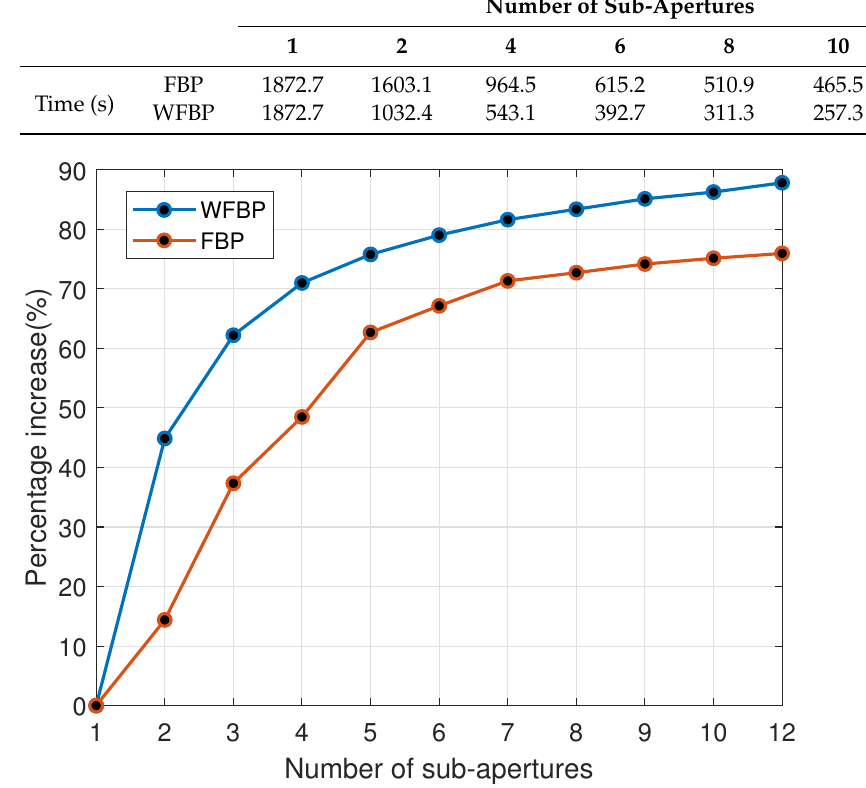
Figure 16. Acceleration effect comparison between the WFBP and FBP